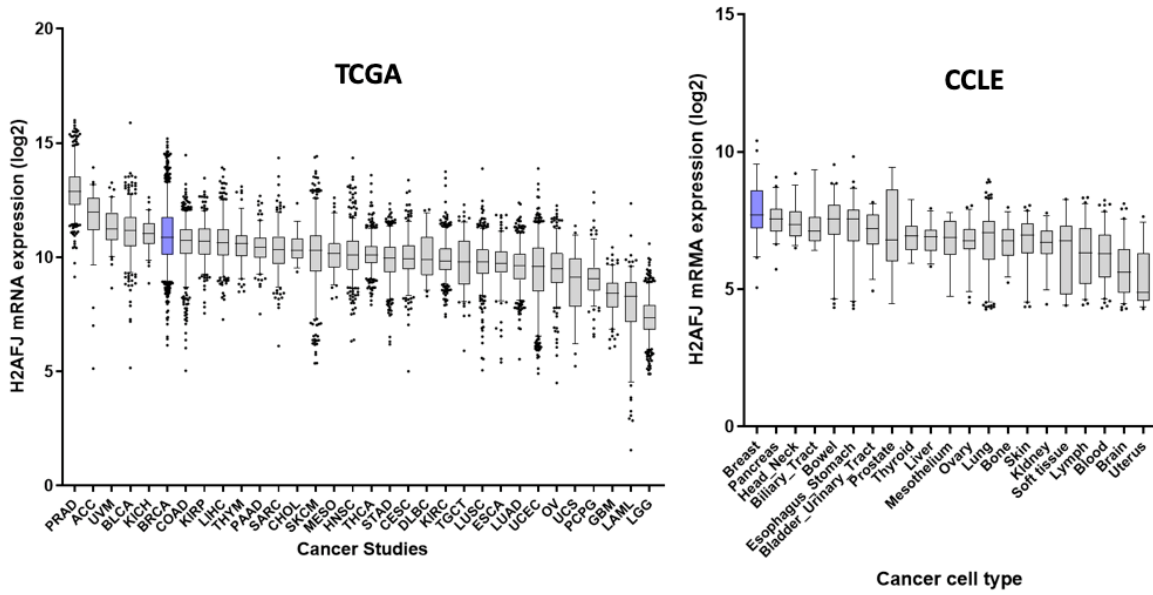
Figure 4. H2AFJ is highly expressed in luminal cancer cells. Left panel : Log2 of H2AFJ RNA levels from transcriptomic data in the Cancer Genome Atlas (TCGA) for prostate adenocarcinoma (PRAD), adrenocorticol carcinoma (ACC), breast carcinoma (BRCA), uveal melanoma (UVM), bladder carcinoma (BLCA), kidney chromophobe carcinoma (KICH), liver hepatocellular carcinoma (LIHC), kidney renal papillary cell carcinoma (KIRP), colon/rectal adenocarcinoma (COAD), thymoma (THYM), skin cutaneous melanoma (SKCM), sarcoma (SARC), pancreatic adenocarcinoma (PAAD), cholangiocarcinoma (CHOL), head and neck squamous cell carcinoma (HNSC), mesothelioma (MESO), diffuse large B-cell lymphoma (DLBC), thyroid carcinoma (THCA), cervical squamous cell carcinoma and endocervical adenocarcinoma (CESC), testicular germ cell tumors (TGCT), stomach adenocarcinoma (STAD), kidney renal clear cell carcinoma (KIRC), lung squamous cell carcinoma (LUSC), uterine corpus endometrial carcinoma (UCEC), esophageal carcinoma (ESCA), ovarian serous cystade- nocarcinoma (OV), lung adenocarcinoma (LUAD), pheochromocytoma and paraganglioma (PCPG), uterine carcinosarcoma (UCS), glioblastoma (GBM), acute myeloid leukemia (LAML), brain lower grade glioma (LGG). Right panel : Log2 of H2AFJ RNA levels from transcriptomic data of cancer cell lines from the Broad Institute Cancer Cell Line Encyclopedia (CCLE). Tissues and cell lines of breast origin are shown in